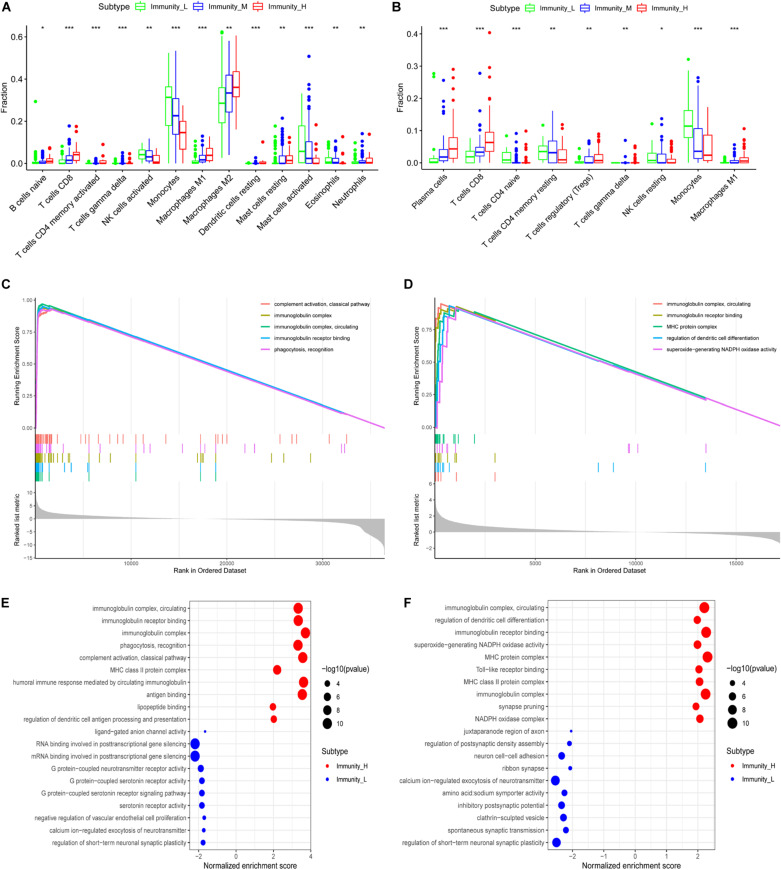
Functional enrichment analysis of genes related to immune gene set by GSEA. The correlation between immune grouping and infiltrating immune cells is based on TCGA (A) and CGGA (B). The GO analysis of differential genes is in TCGA (C) and CGGA (D), and the results are visualized in TCGA (E) and CGGA (F), *P < 0.05, **P < 0.01, ***P < 0.001.